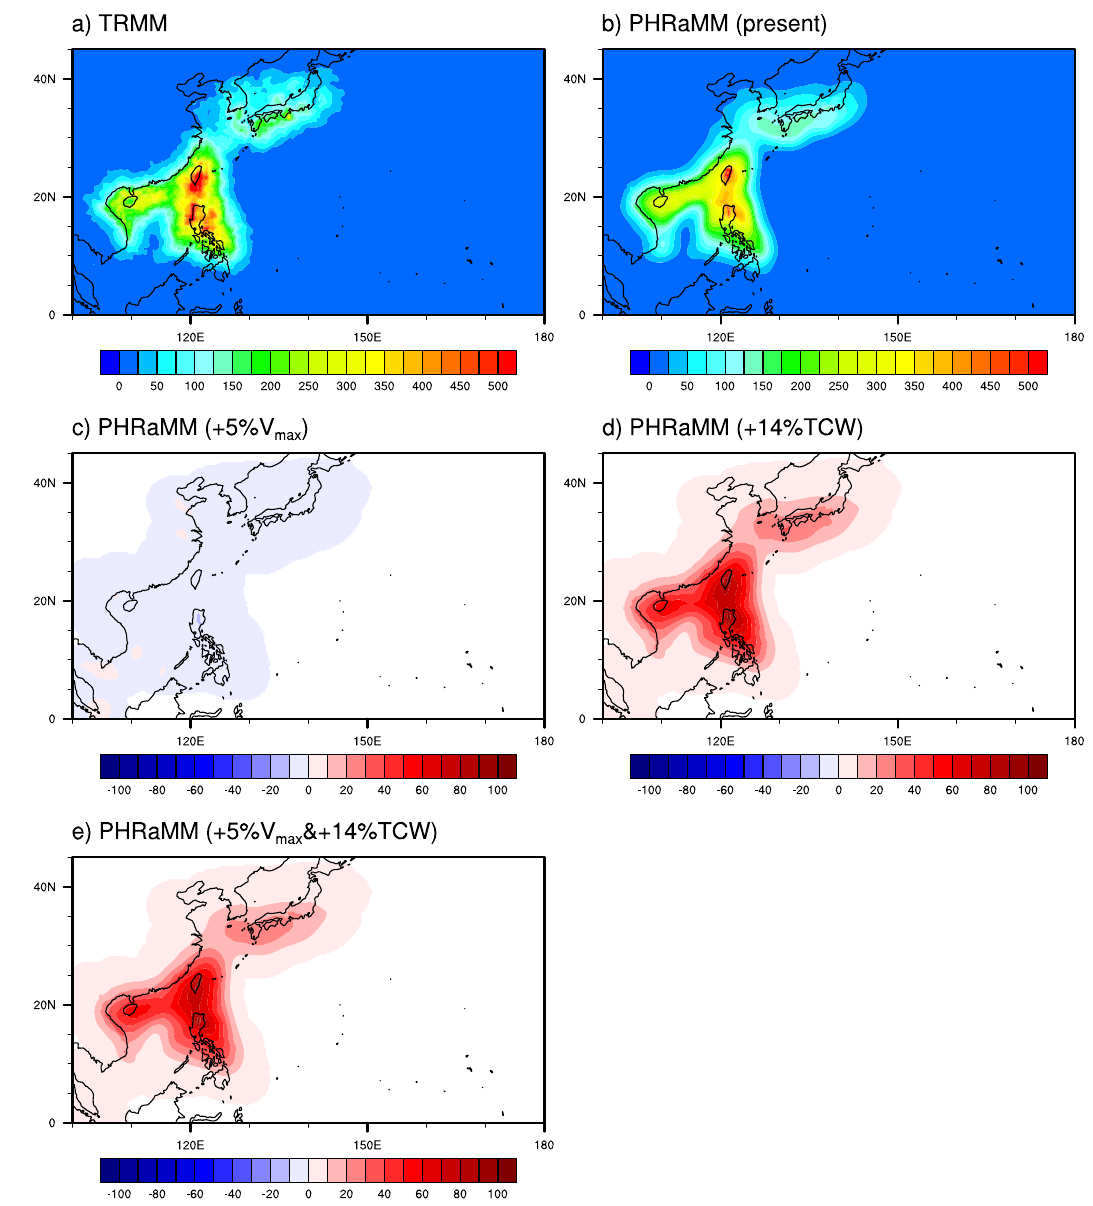
Fig. 2 Annual mean accumulated TC rainfall during the landfall period in the present climate and future climate. a The TRMM and b PHRaMM for the present climate. Future changes compared to the present climate according to the c increase in V max by 5%, d increase in TCW by 14%, and e increase in